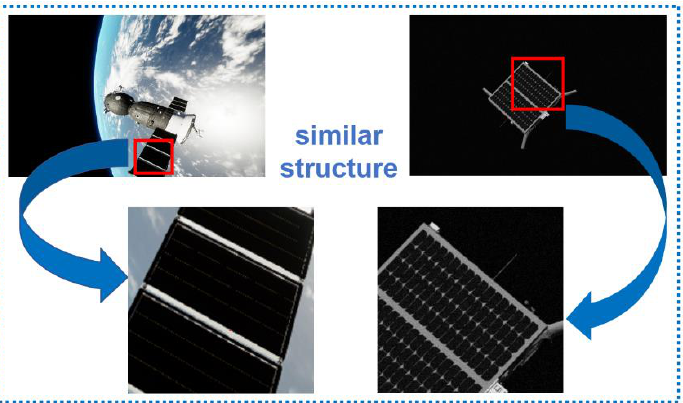
Figure 14. Comparison diagram of similar structures of different spacecraft.